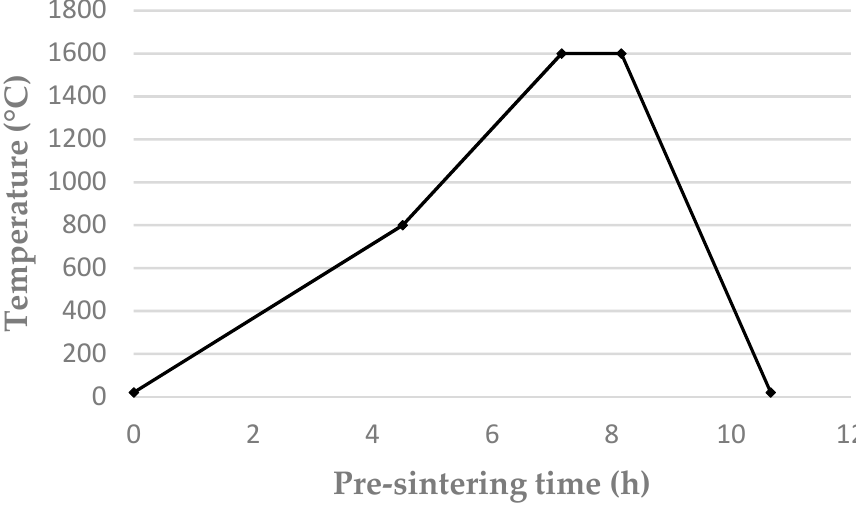
Figure 1. Temperature curve of the ceramic preforms pre-sintering process.